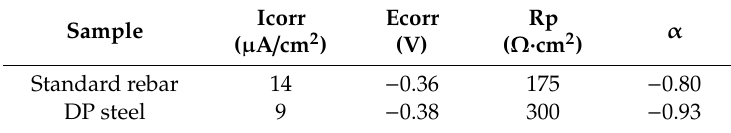
Table 3. EIS results for DP steel and standard rebar in 0.9 M NaOH (pH = 13.9) + 0.2% Cl −